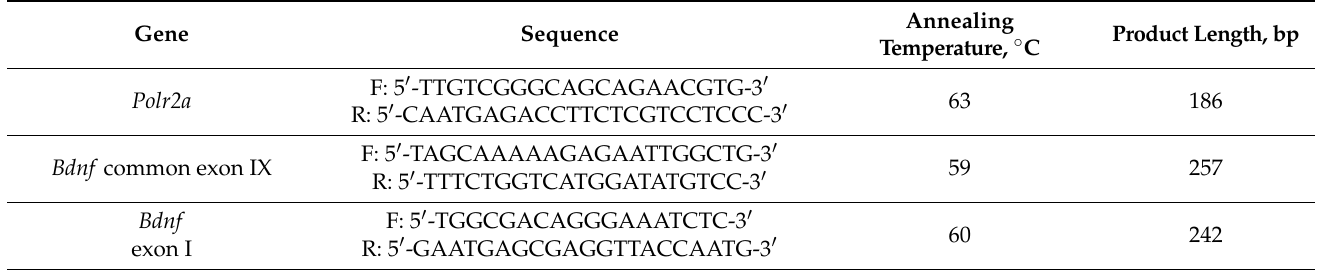
Table 1. The primer sequences, annealing temperatures, and amplicon lengths. Gene Sequence